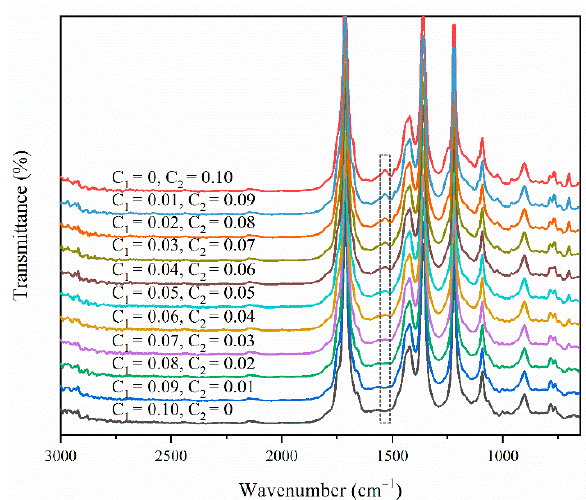
Figure 11. ATR-FTIR spectra of S -valsartan (C 1 : the concentration of S -valsartan, unit: g·mL − 1 ) and sacubitril (C 2 : the concentration of sacubitril, unit: g·mL − 1 ) in acetone of different concentration at a fixed temperature of 298.15 K.